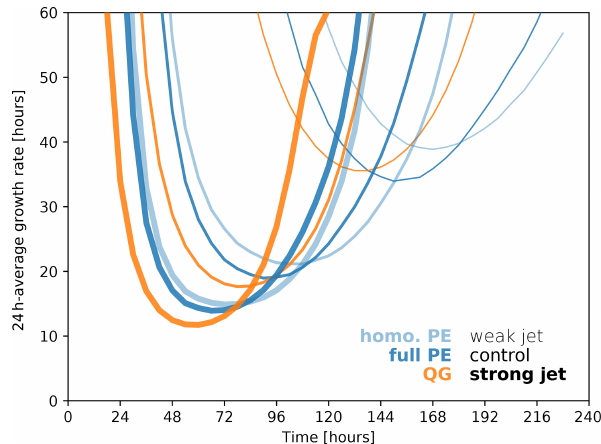
Figure 3. Growth rate of eddy kinetic energy averaged over 24h periods for QG (orange) and the two variants of PE (blue, light blue). Line weight indicates the initial and jet strength with max- imum winds of 30ms − 1 (thin), 50ms − 1 (medium), and 70ms − 1